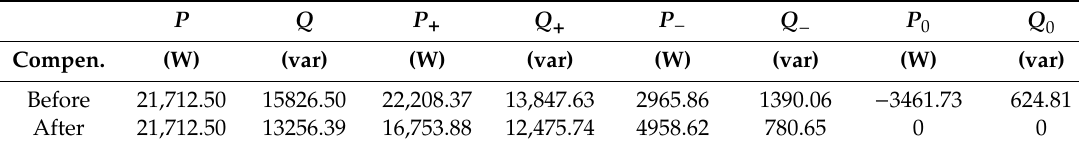
Table 5. Comparison of powers, before and after including the ZSCC